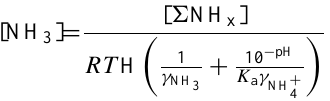
For adsorption coefficient of ammonium at top 2cm